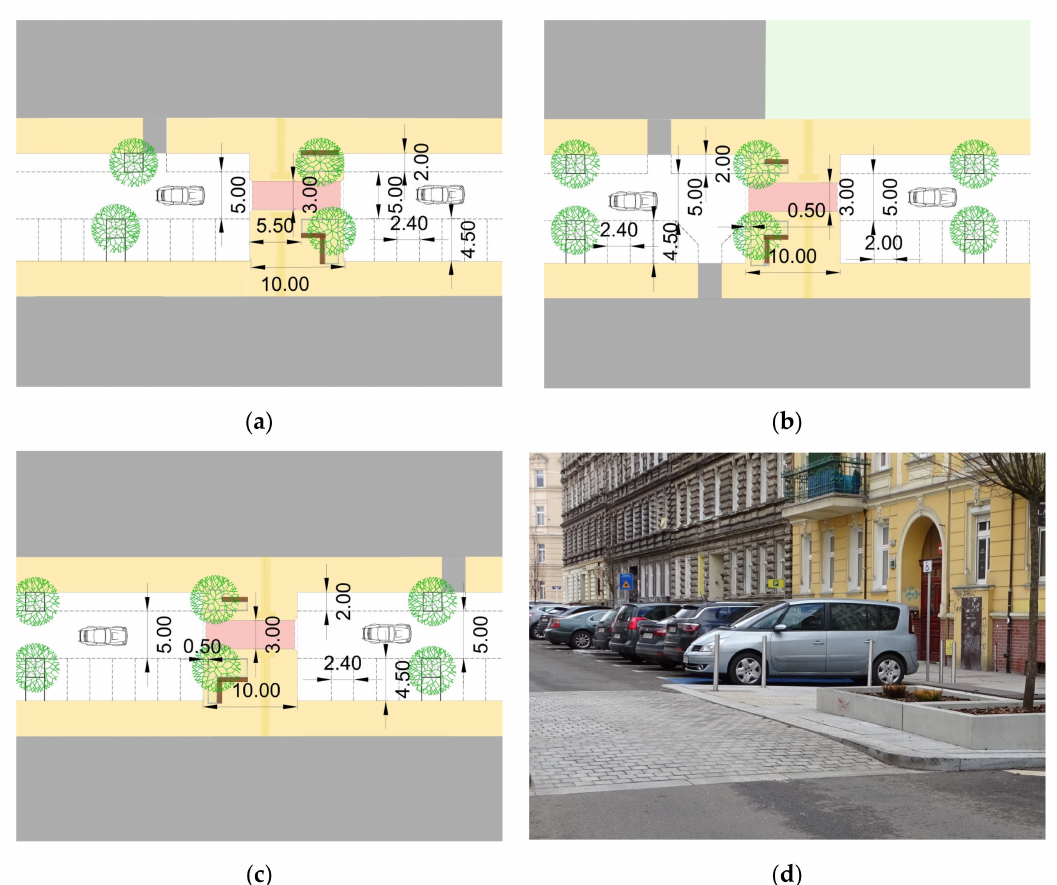
Figure 6. Treatments of chokers/raised pedestrian crossings: ( a ) testing ground No. 1; ( b ) testing ground No. 2; ( c ) testing ground No. 3; ( d ) design details of the sinusoidal approach ramp to the raised crossing and a view of a concrete planter. Source: own work of the author based on the design documentation [40].